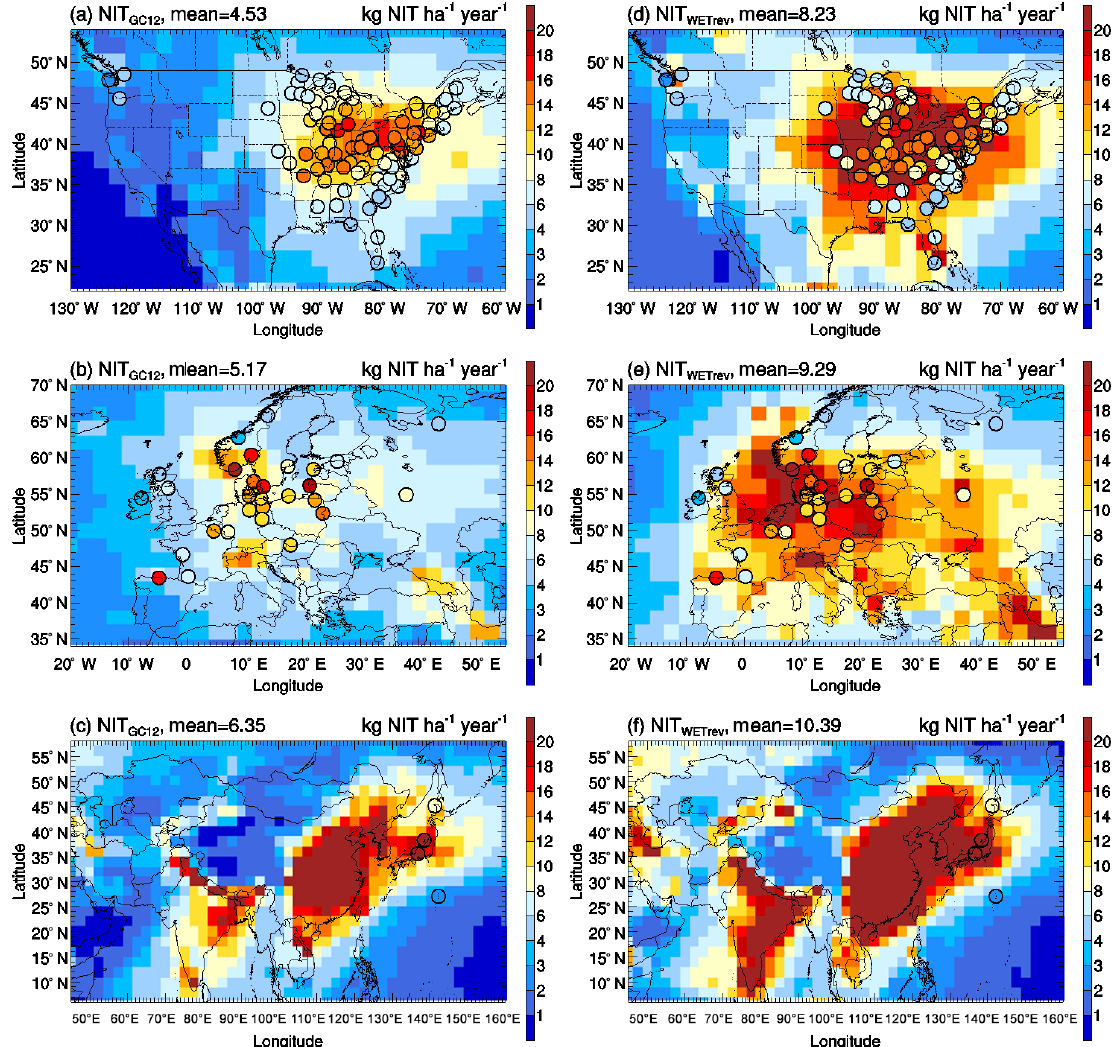
Figure 4. The same as Fig. 3 but for HNO 3 +